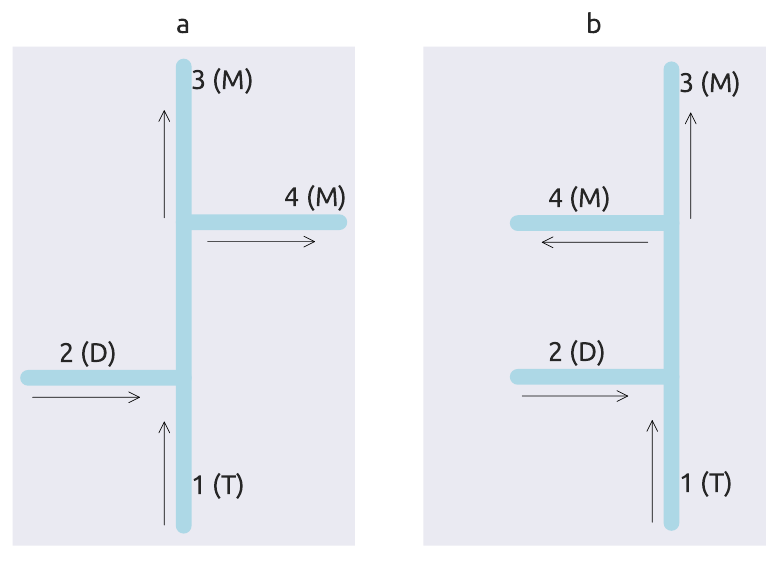
Figure 1. Two different experimental configurations with variable distance between two Tee junctions where inlet pipes are labeled as 1 and 2 and outlet pipes as 3 and 4. D represents distilled water, T represents tap water and M represents mixture: ( a ) Distilled water inlet and mixture outlet branch on opposite sides (configuration S). ( b ) Distilled water inlet and mixture outlet branch on the same side (configuration U). Investigated distances between Tee junctions are 5.6D, 10D, 15D, 20D, 25D, 30D, 70D, 120D, 130D and 150D for both configurations. The distance between Tee junctions refers to the centerline distance of pipe 2 and pipe 4. The 5.6D distance is the smallest one that could be physically constructed due to tees design. Investigated inlet flows range from 0.08 l/s to 0.43 l/s (Reynolds numbers range from 6000 to 30,000 in inlet pipes) and are regulated with valves to obtain different inlet volume flow ratios. Flow ratios considered for distances 5.6D, 10D and 15D at inlet branches are 3:1, 2:1, 1:1, 1:2 and 3:1 while for all other distances the ratio is 1:1. Flow at the outlet is regulated to be the same in both pipes for all experimental runs. A complete overview of the experiment can be seen in Table 1 and a schematic of the experiment can be seen in Figure